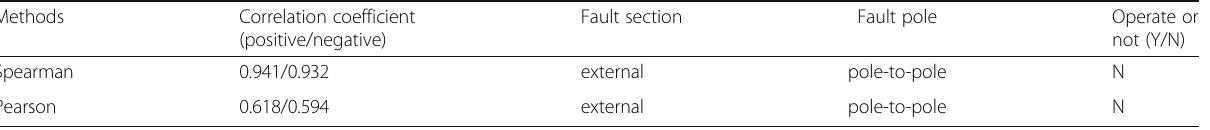
Table 5 Protection results with different correlation coefficients